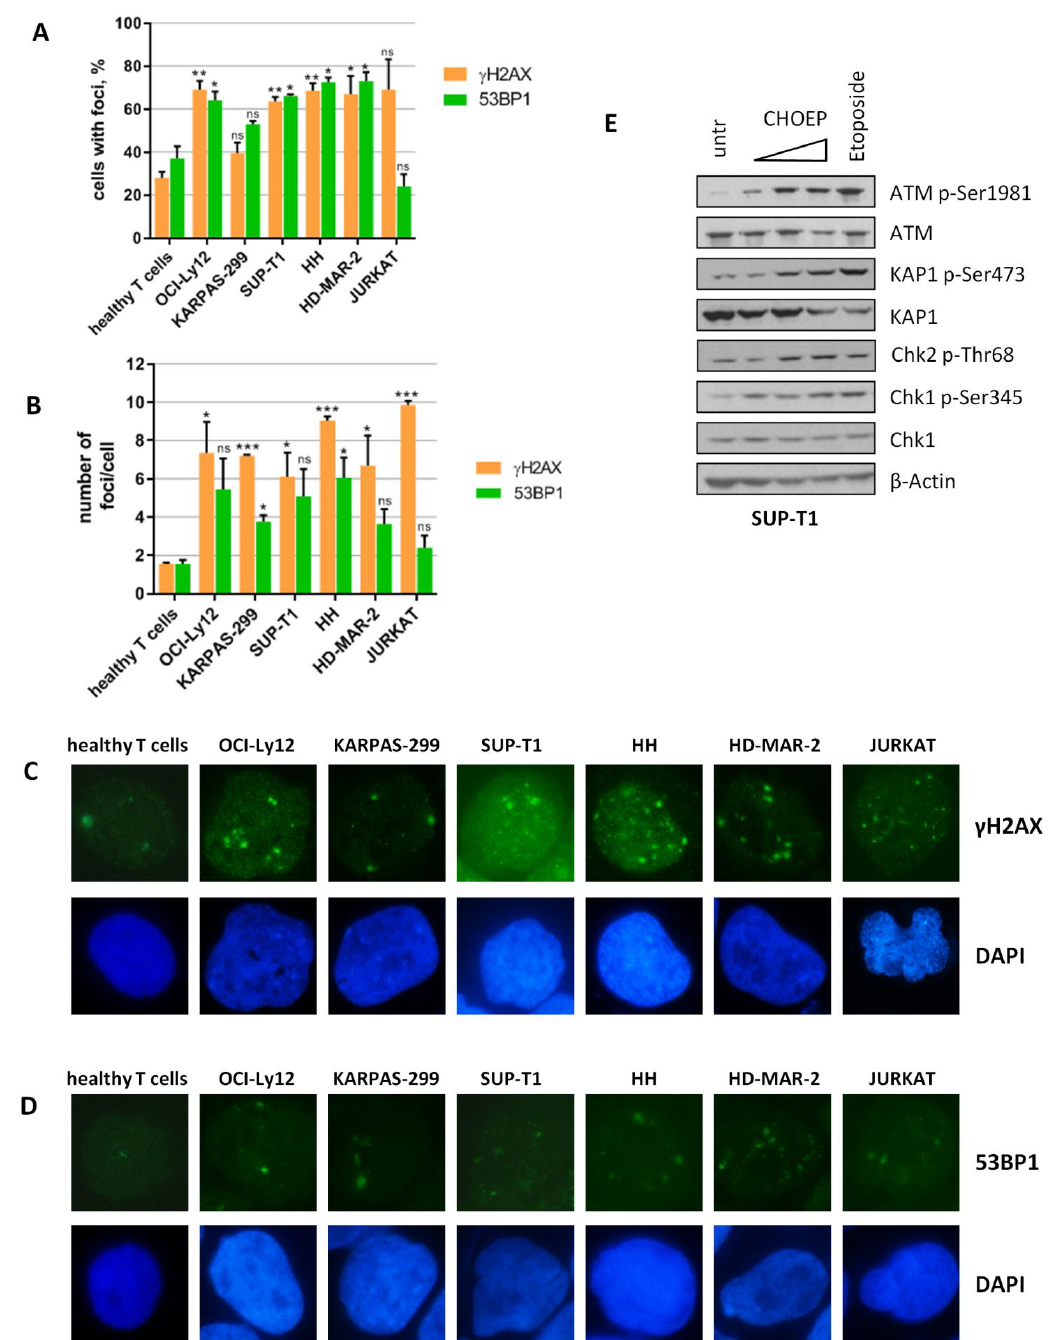
Figure 1. TCL cell lines show intrinsic DNA damage and basal activation of DDR. Healthy T lymphocytes isolated from healthy donors and malignant T cell lines (OCI-Ly12, KARPAS-299, SUP-T1, HH, HD-MAR-2, and JURKAT) were subjected to immunofluorescence for the evaluation of γ H2AX or 53BP1 foci ( A , B ). The percentage (%) of cells displaying foci and the number of foci/cell in the subsets of cells with detectable foci are reported in ( A , B ), respectively. Data are expressed as the mean ± SD of independent experiments. Asterisks indicate statistically significant differences between each cell line and healthy T lymphocytes (* p < 0.05; ** p < 0.01; *** p < 0.001; ns: not significant). Representative immunofluorescence images ( C , D ) of experiments described in ( A , B ), original microscope magnification 100 × . SUP-T1 cells were exposed to increasing concentrations of CHOEP (IC 50 , 4 × and 8 × , as in [5]) or to 20 µ M etoposide for 3 h. After harvesting, untreated and treated cell lysates were analyzed by Western blot using the indicated antibodies ( E ).